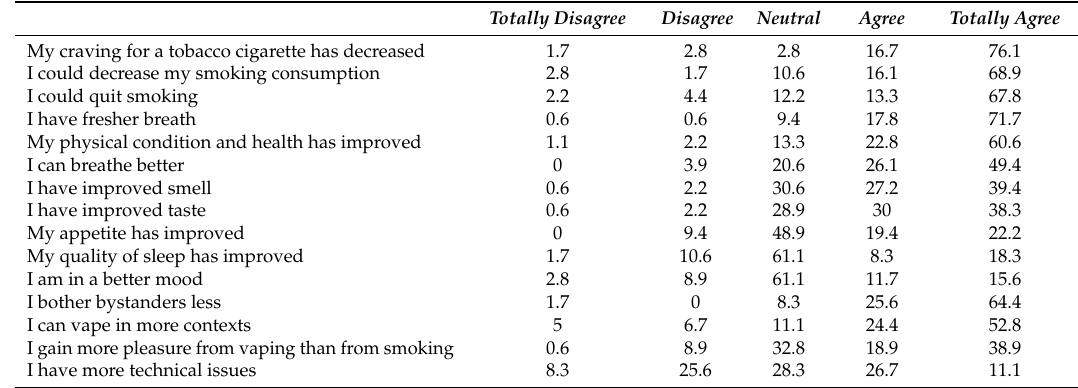
Table 5. Distributions of responses (in %) by current vapers ( n = 195) on a list of several possible improvements due to using e-cigs (on a scale from totally disagree to totally agree ). Totally Disagree Disagree Neutral Agree Totally